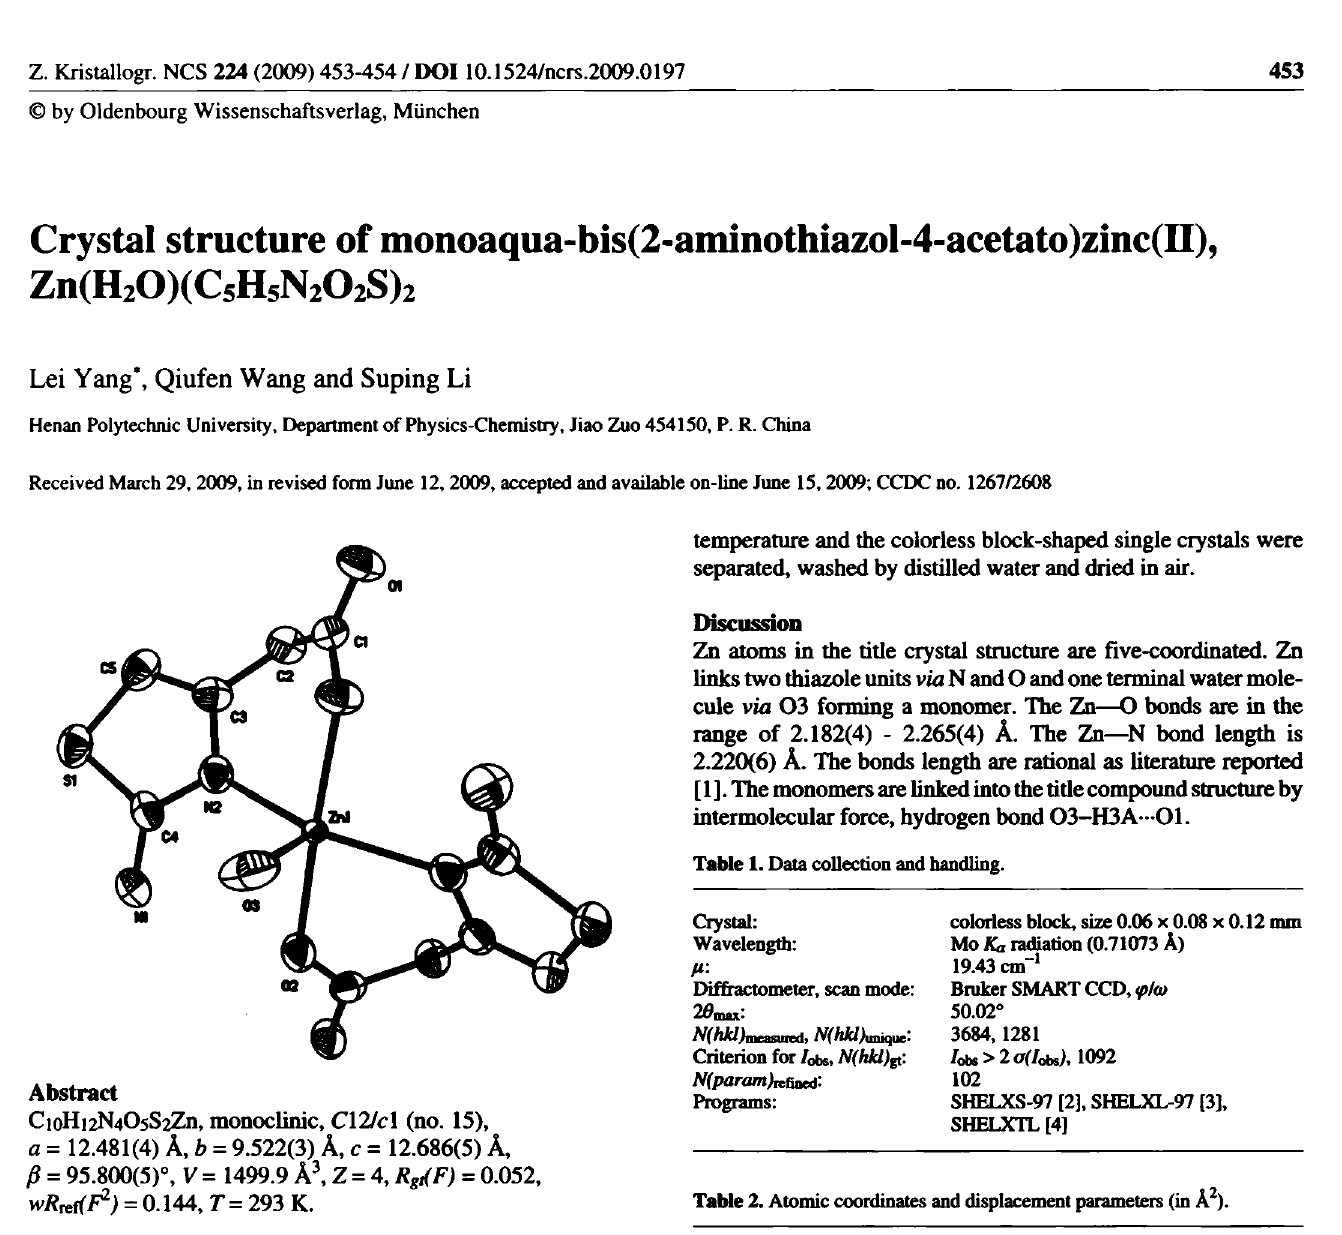
Table 2. Atomic coordinates and displacement parameters (in Â 2